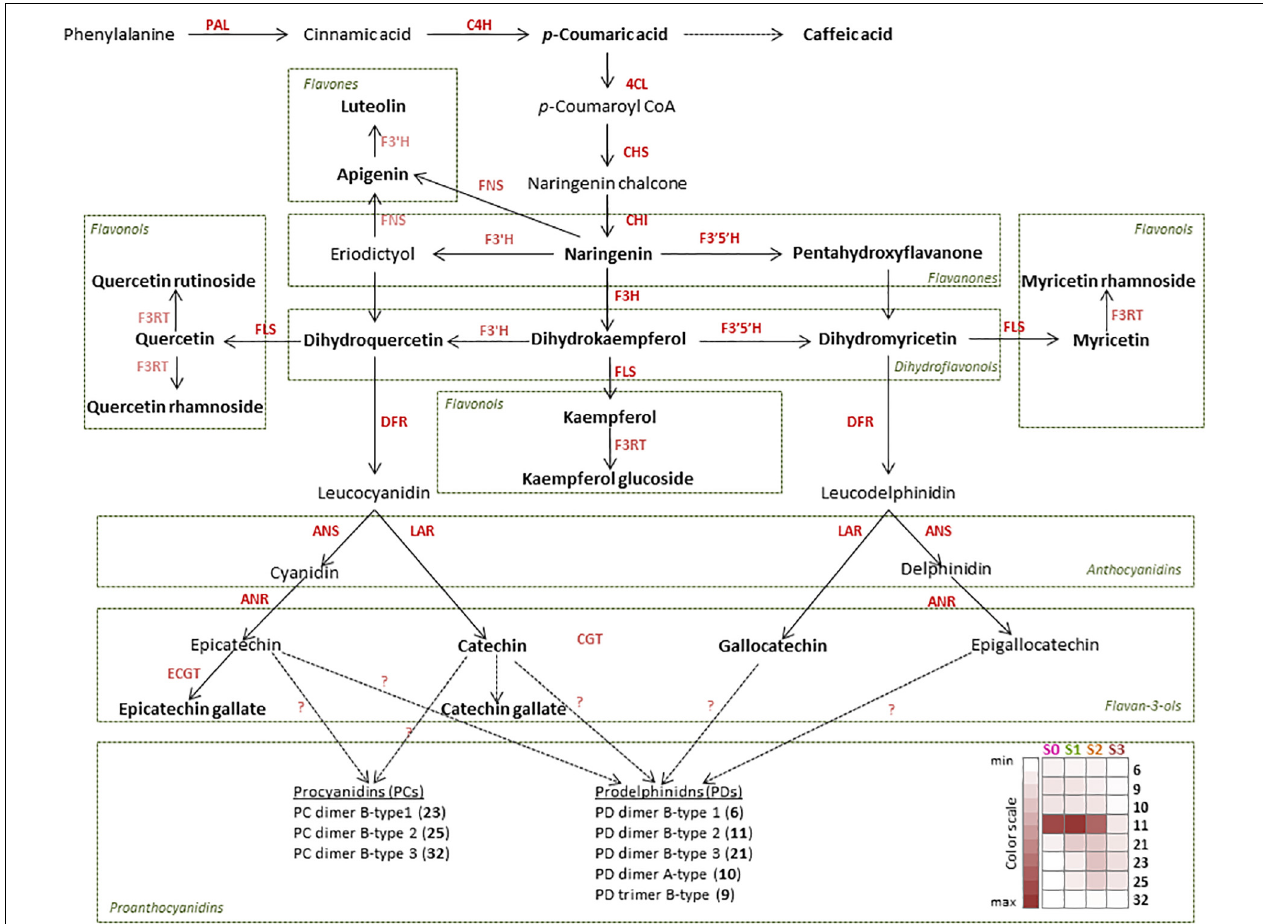
FIGURE 1 | Proposed flavonoid biosynthetic pathway in Cistus creticus subsp. creticus fruit. Compounds in boldface letters are detected in flowers and in fruit of different developmental stages. Enzymes in boldface letters are those for which the gene expression analysis was performed: phenylalanine ammonia-lyase (PAL), cinnamate 4-hydroxylase (C4H), 4-coumarate:coenzyme A ligase (4CL), chalcone synthase (CHS), chalcone isomerase (CHI), flavanone-3 β -hydroxylase (F3H), dihydroflavonol-4-reductase (DFR), flavonoid-3 (cid:48) -hydroxylase (F3 (cid:48) H), flavonoid 3 (cid:48) ,5 (cid:48) -hydroxylase (F3 (cid:48) 5 (cid:48) H), flavonol synthase (FLS), leucoanthocyanidin reductase (LAR), anthocyanidin synthase (ANS), and anthocyanidin reductase (ANR). Heat map based on the peak areas presents the amounts of proanthocyanidins (PAs) in Cistus flowers (S0) and fruits of three developmental stages (S1–S3). The values are represented by the intensity of the red color as indicated on the color